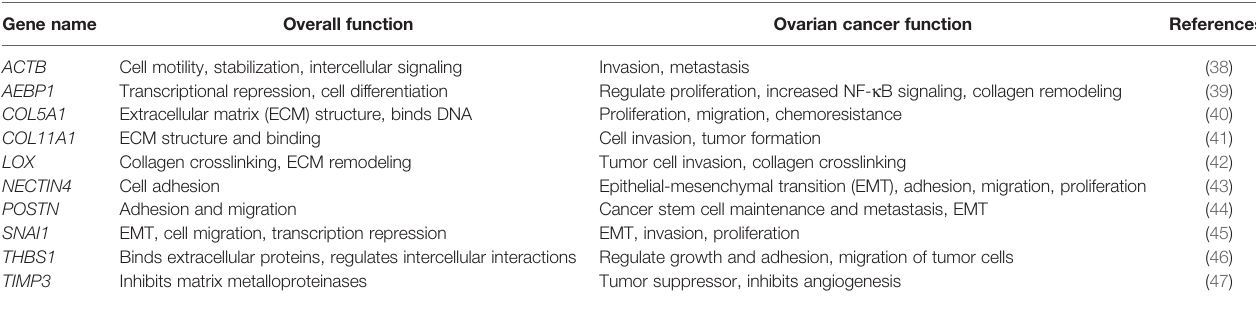
TABLE 1 | Genetic biomarkers of ovarian